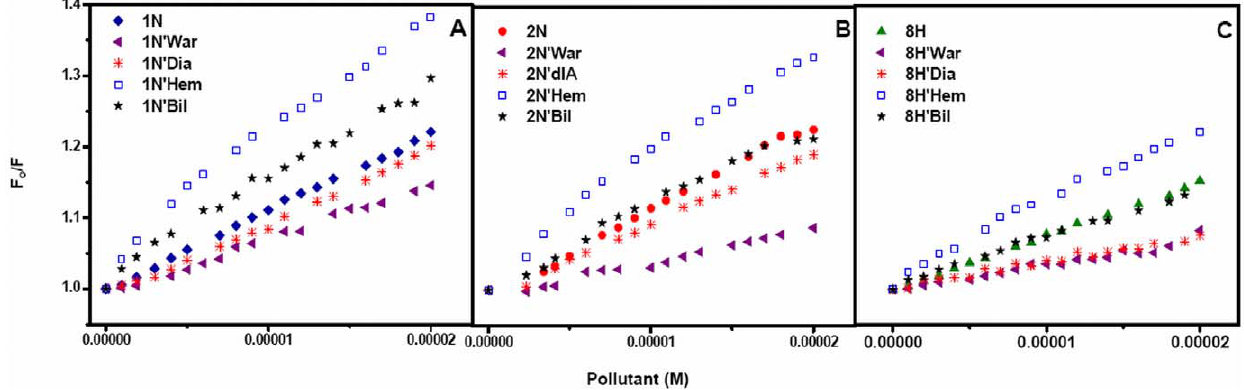
Figure 8. Competative binding of (A) 1N, (B) 2N and (C) 8H to HSA in the presence of site markers at 35 6 C. [HSA=2 m M; site markers=4 m M; 1N=2N=8H=0–50 m M].